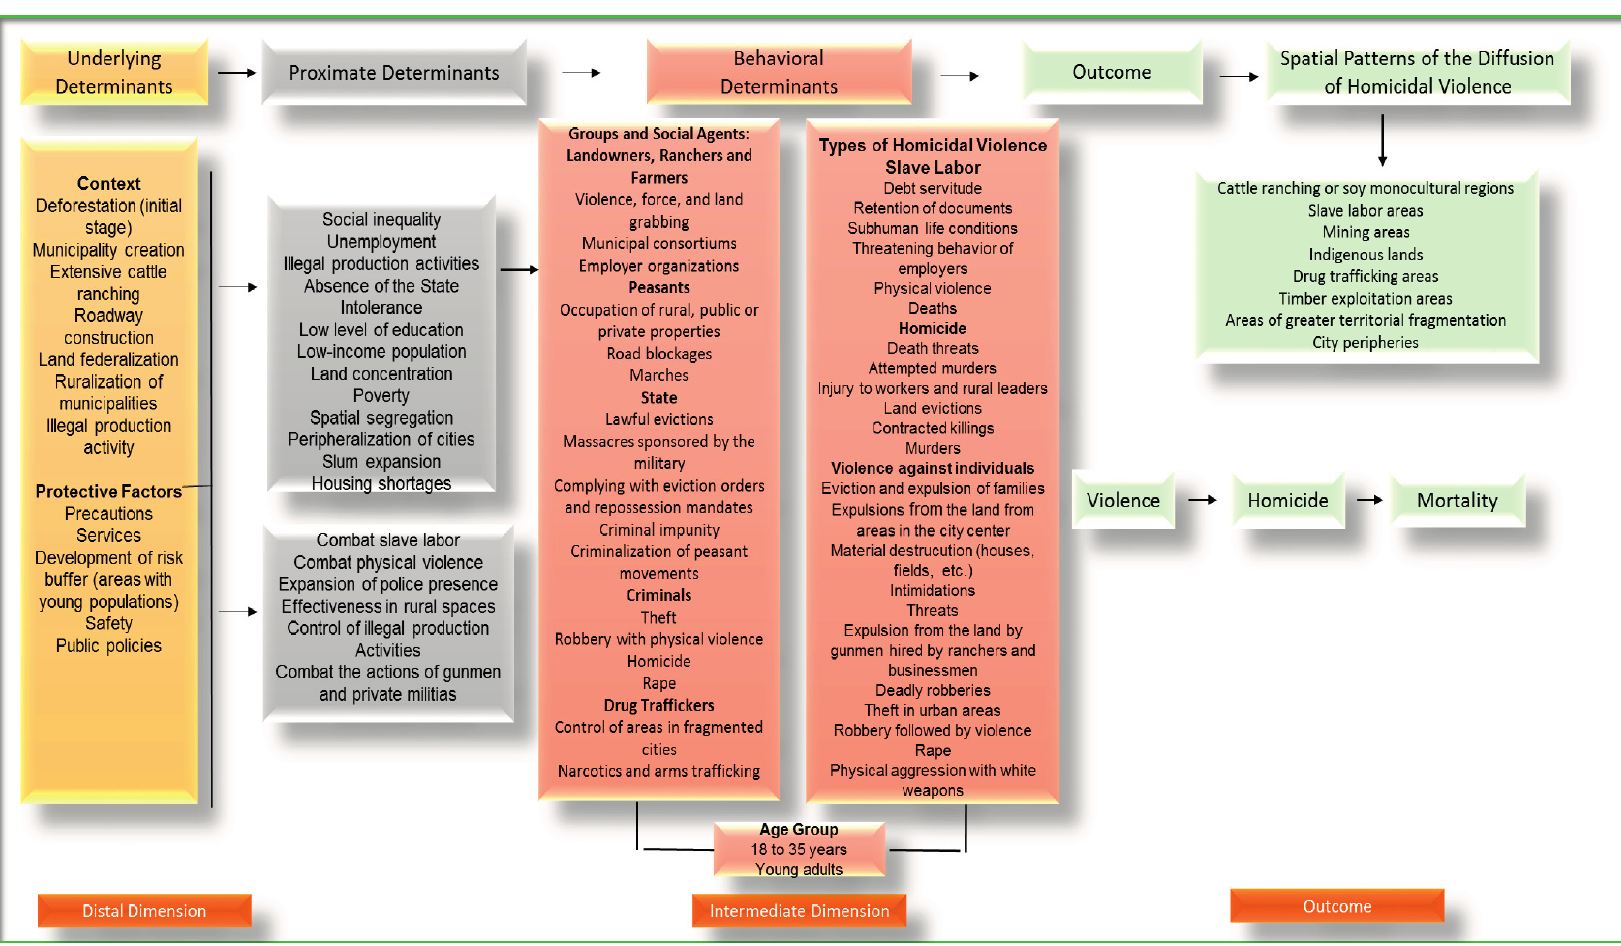
Figure 4. Proximate-determinants conceptual framework for factors affecting the risk of violence in the regional